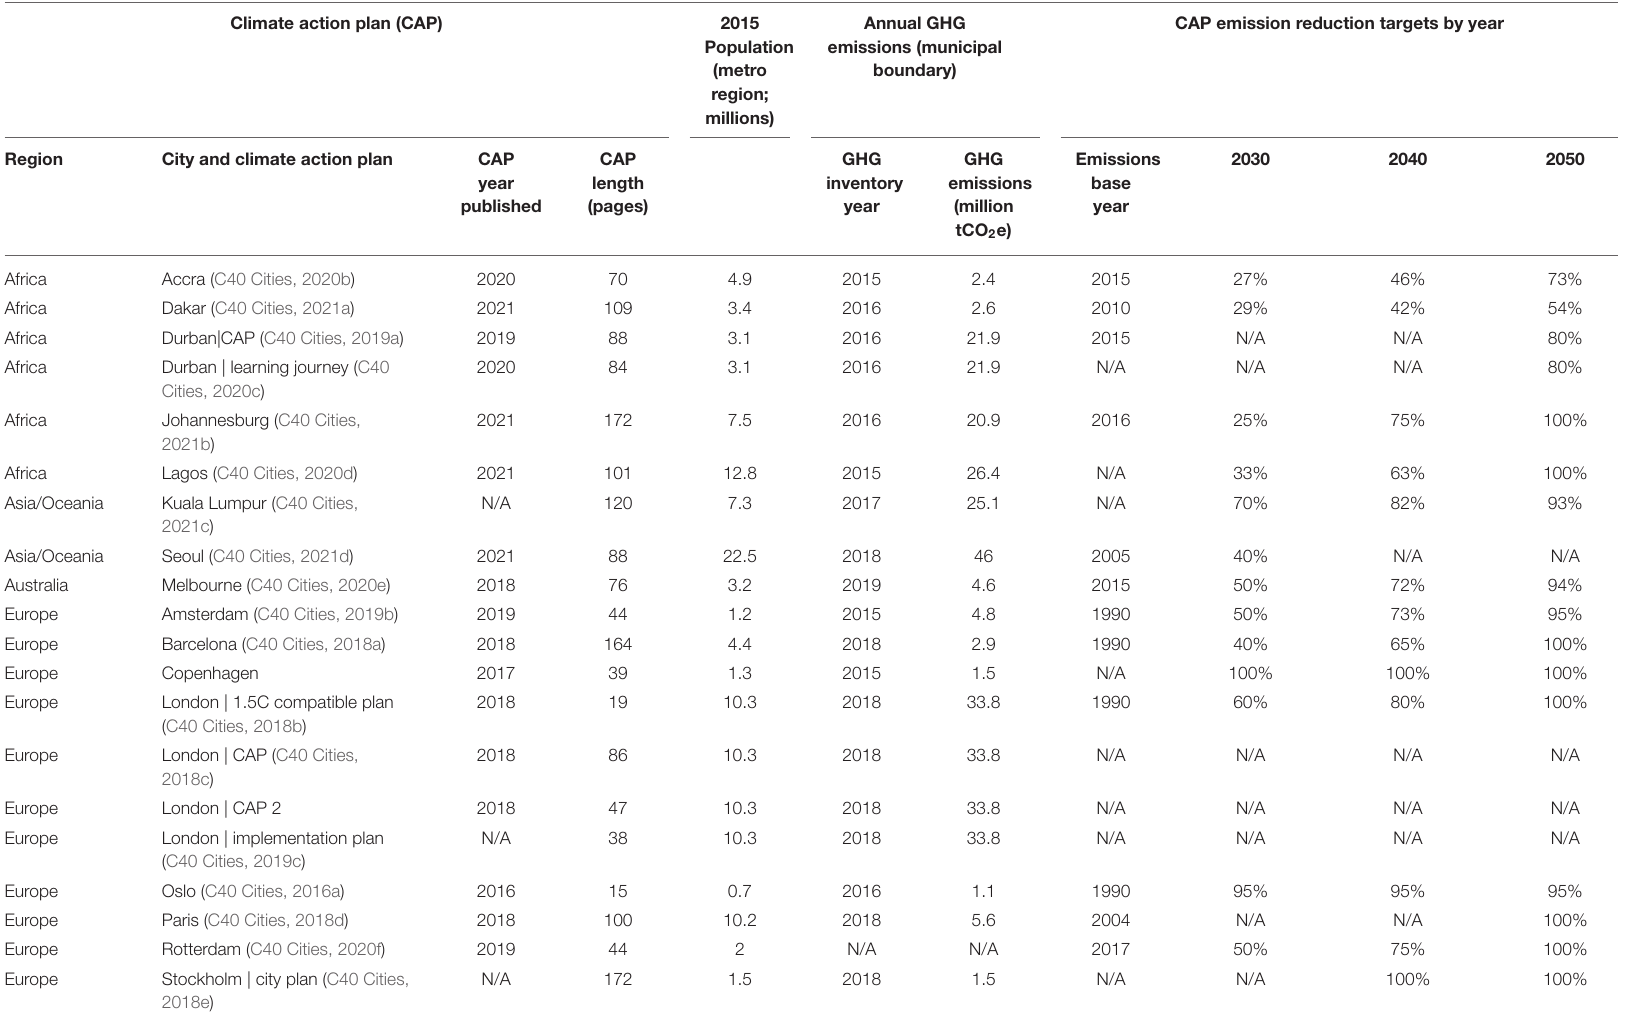
TABLE 2 | Characteristics of each city in our review, including population, total urban GHG emissions for the most recent year of self-reported inventory, the year the CAP was published, and GHG emission reduction targets contained within the